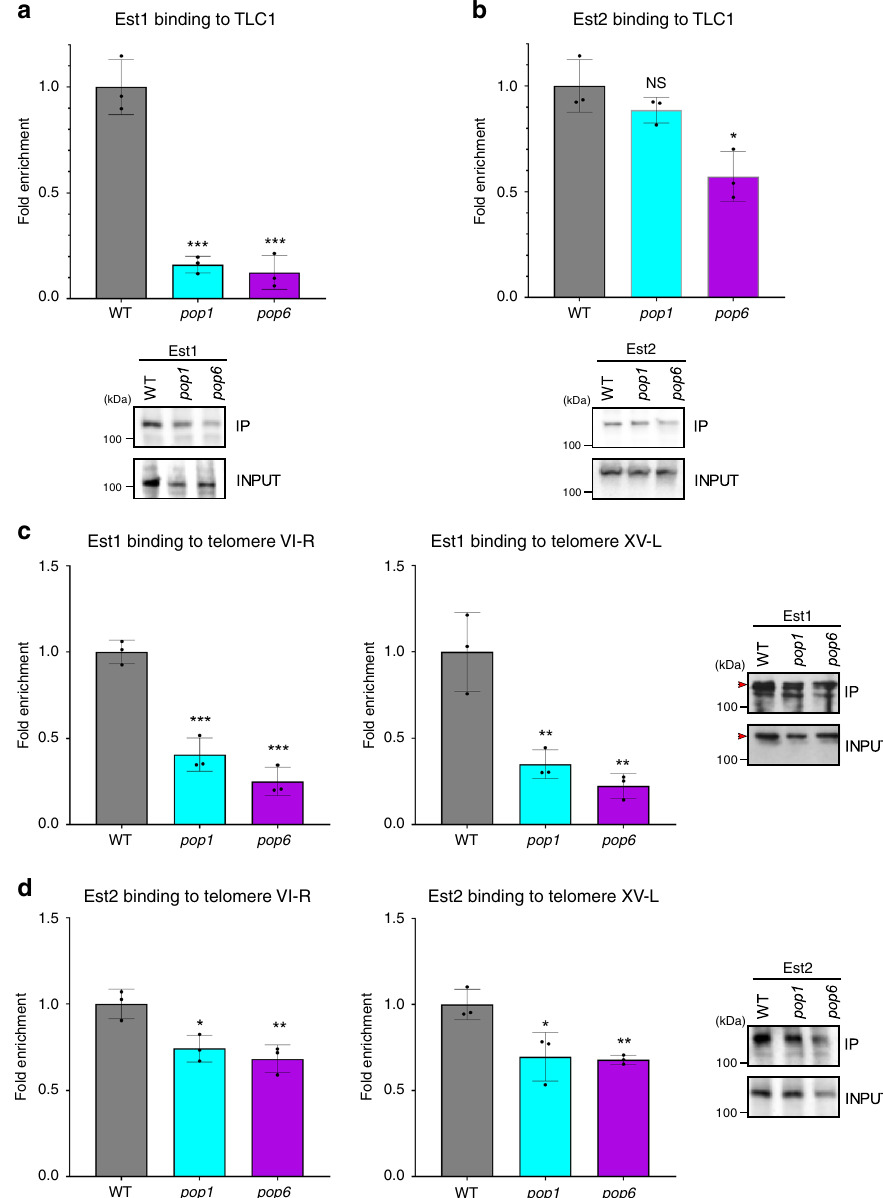
Fig. 7 Telomerase holoenzyme assembly and telomerase binding to telomeres is de fi cient in pop cells at 24 °C. RNA immunoprecipitations were done in WT (gray bars), pop1 (blue bars) and pop6 (purple bars) cells expressing a Est1-MYC or b Est2-MYC. Extracts prepared from cells grown at 24 °C for ~50 generations were immuno-precipitated with anti-MYC antibody, and the amount of TLC1 in each precipitate was determined by RT-qPCR. The IP/INPUT levels of TLC1 were normalized to the IP/INPUT levels of ACT1 mRNA in each sample. The average TLC1/ACT1 ratios in WT cells were de fi ned as one. Fold enrichment and signi fi cance in pop cells is relative to WT. Chromatin immunoprecipitation assays in WT, pop1 and pop6 cells grown at 24 °C for ~50 generations to determine the association of c Est1-MYC or d Est2-MYC to telomeres VI-R (left) and XV-L (right). The level of telomeric sequence in the IP/ INPUT was normalized to the amount of ARO1 DNA in the IP/INPUT of the same sample. The average ratio of telomeric DNA to ARO1 in WT cells is de fi ned as one. Fold enrichment and signi fi cance in pop1 and pop6 cells is relative to WT. Western blots of Est1-MYC or Est2-MYC in both the input and immuno-precipitates (IP) demonstrate that similar amounts of Est1 and Est2 were immuno-precipitated in WT and pop cells at 24 °C. Red arrowheads in c) indicate the band for Est1-Myc. Biological replicates in a-d are shown as black circles. Error bars are one standard deviation from the average value of three or more independent experiments. P -values were calculated using unpaired two-tailed Student ’ s t -test; * P ≤ 0.05 , **P ≤ 0.01, *** P ≤ 0.001, **** P ≤ 0.0001; NS, not signi fi cant, P >0.05. Source data are provided as a Source Data fi only seven nucleotides in the P3-like CS2a domain where Pop6 additional regions of statistically signi fi cant modi fi cation in the and Pop7 bind (Fig. 8e). The higher DMS reactivity of these pop6 strain (Supplementary Figs. 5 – 7). Thus, the structure of nucleotides can be explained by a reduction in Pop1/6 binding NME1 RNA is globally altered in pop1 and pop6 cells even at 24 °C. that normally shields them from DMS modi fi cation (Fig. 1a). Unexpectedly, TLC1 had a single, short region that was This lower binding is expected as Pop1 was present at ~45% of differentially DMS reactive in pop versus WT cells at 24 °C WT levels in pop1 and pop6 cells at 24 °C (Fig. 2f, g). There were (Fig. 8d; Supplementary Fig. 9). The altered region consisted of